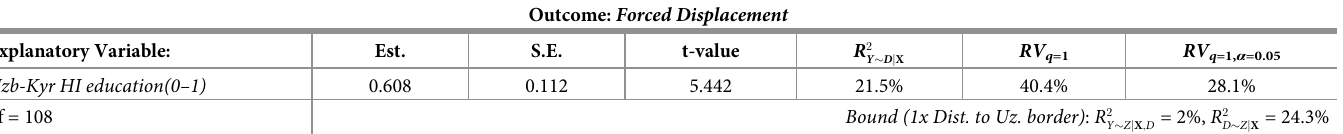
Table 6. Sensitivity: Community